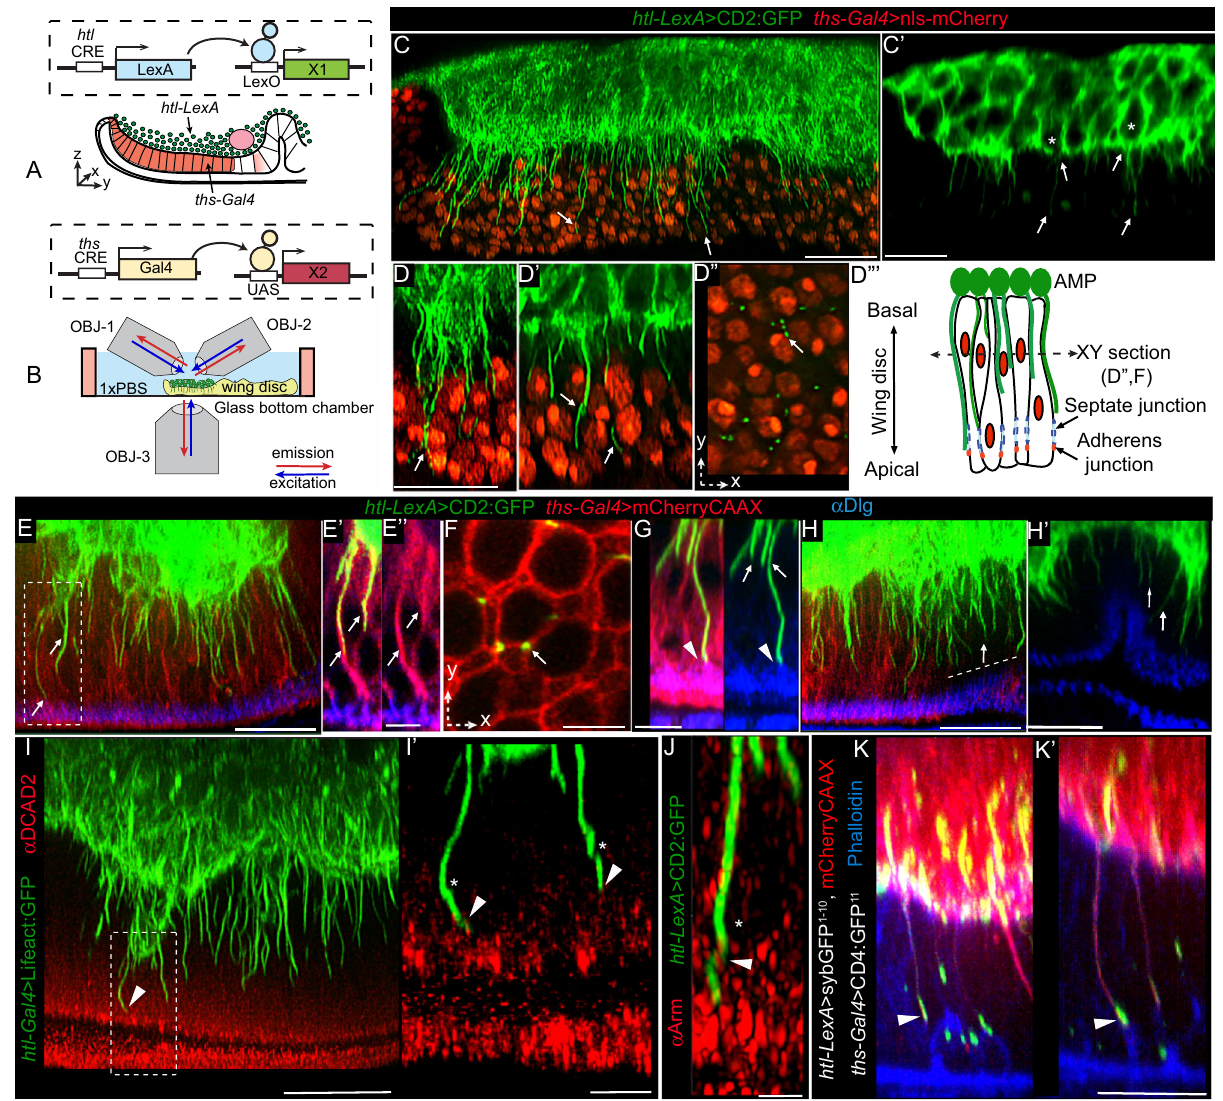
Fig. 3 AMP cytonemes anchor AMPs to the wing disc adherens junctions. A , B Schematic depictions of the genetic strategy ( A ) used to simultaneously mark AMPs and the disc notum, and imaging strategy ( B ) using multi-view microscopy for deep-tissue imaging. C , D ”’ Triple-view confocal imaging showing CD2:GFP-marked orthogonally polarized cytonemes (arrow) emanating from disc-proximal AMPs (*, in C ’ ) and invading through the intercellular space between nls:mCherry-marked disc cells ( C , D , D ’ ); D ” - D ”’ single XY cross-sections of disc, as illustrated in D ”’ , showing multiple cytonemes